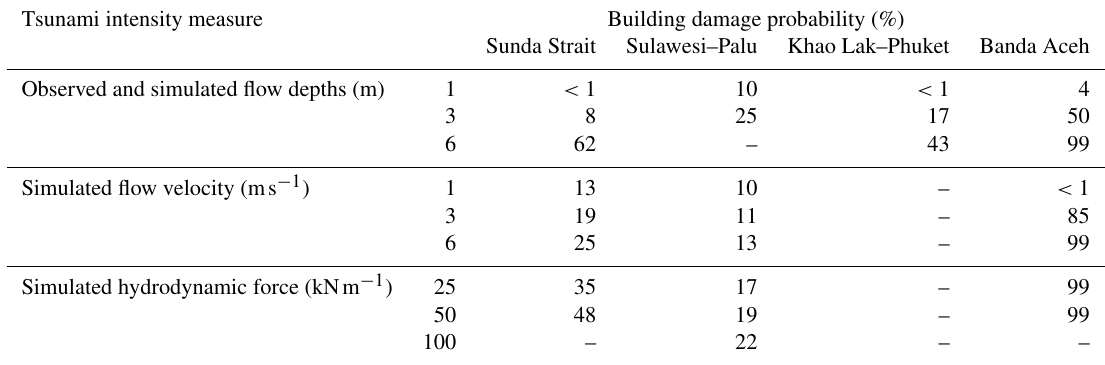
Simulated hydrodynamic force (kNm − 1